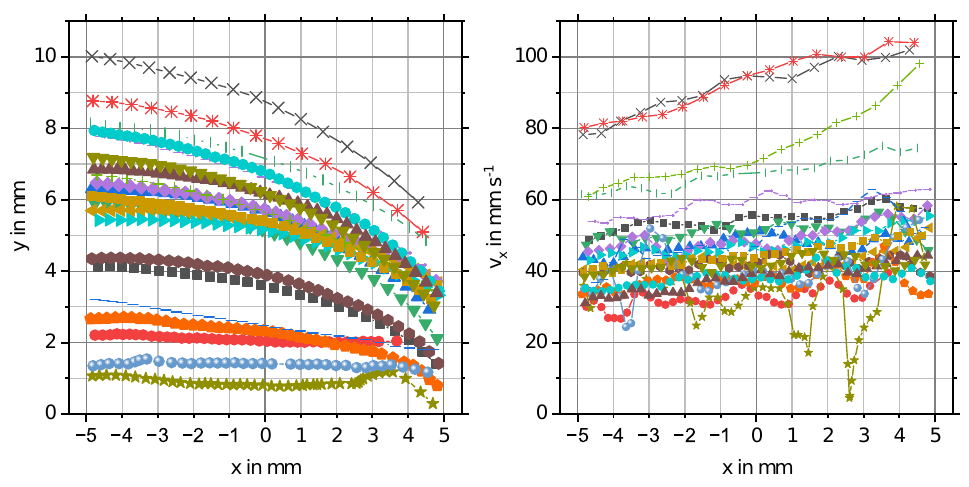
Figure 8. Tracer particles carried by the overflowing foam ( c 1 = 1.0gL − 1 ) in the central measuring plane ( z 0 = 0mm) at the weir: along their motion paths, the horizontal velocity component v x is plotted over the horizontal position x . The same tracer particle is indicated by the same symbol and colour in both